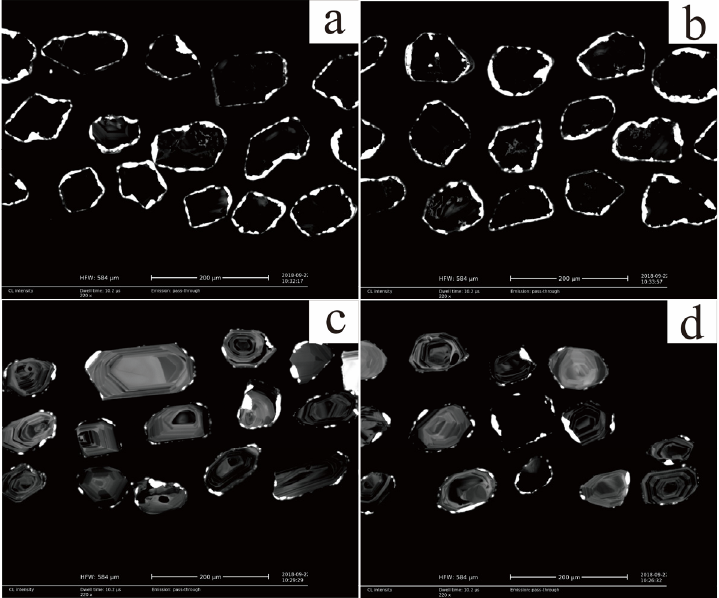
Figure 7. Cathodoluminescence images of the altered gabbro zircon from the gabbro: ( a , b ) Neopro- terozoic zircon and ( c , d ) Caledonian zircon.